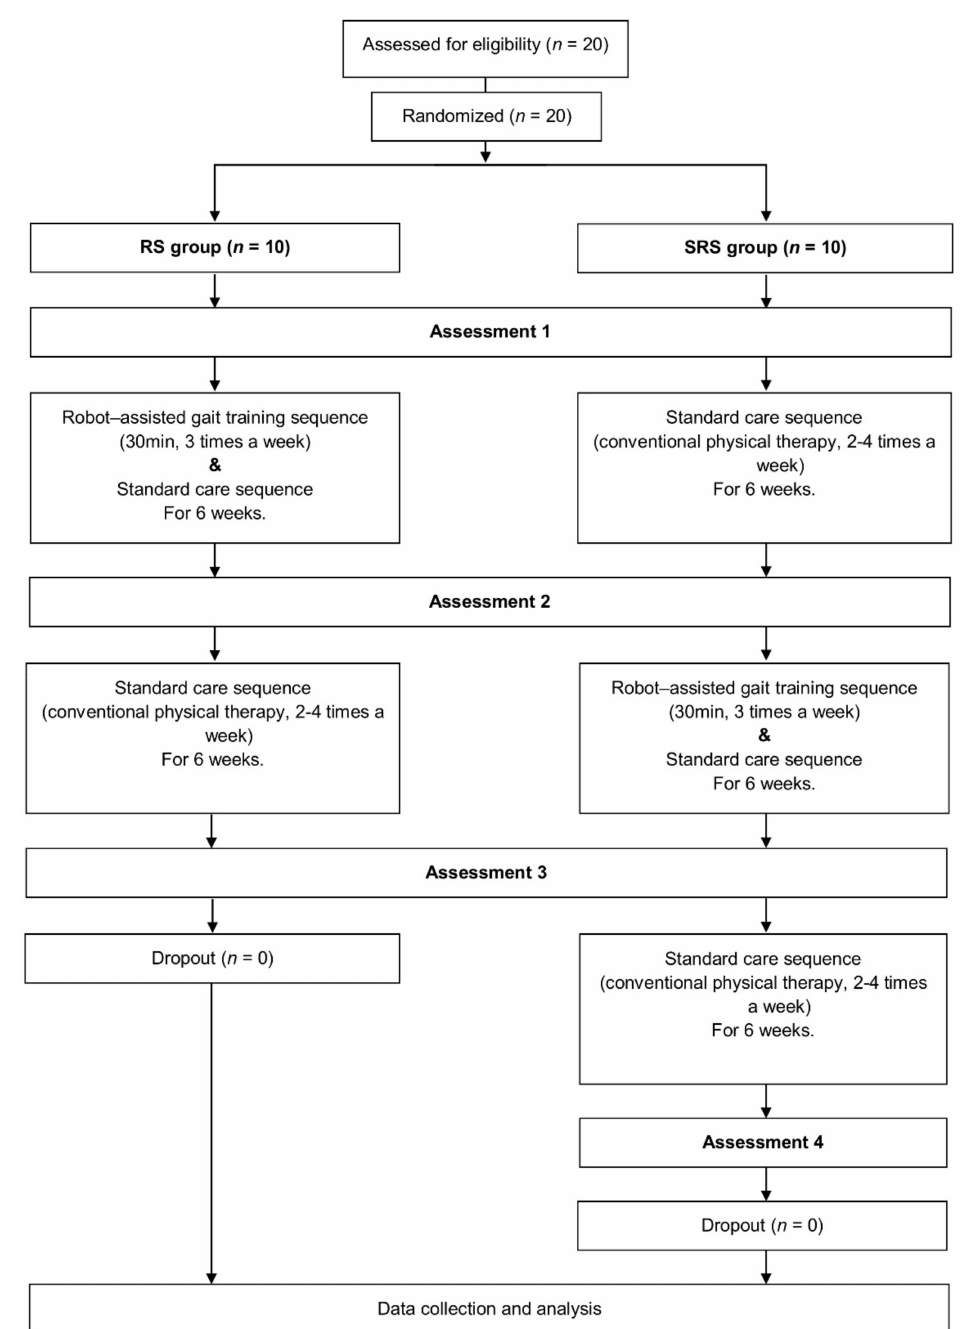
Figure 1. Flow diagram of the study. Abbreviations: RS, robot-assisted gait training / standard care sequence group; SRS, standard care / robot-assisted gait training / standard care sequence